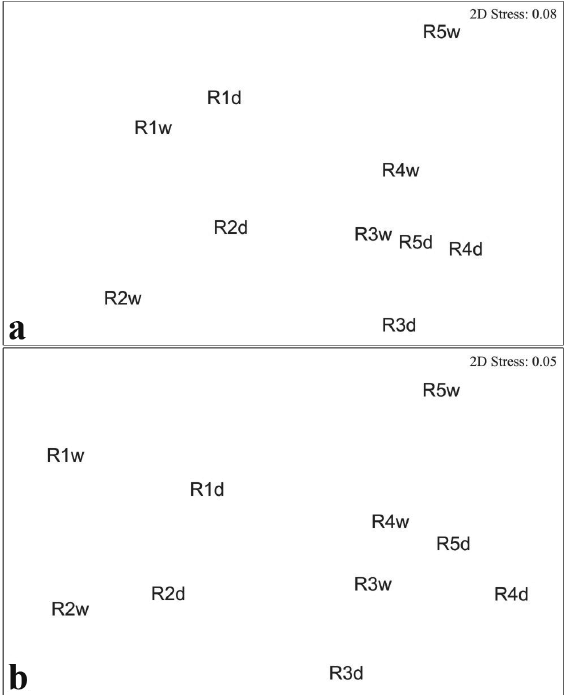
Fig. 2. Two-dimension ordinations based on Jaccard similarity coefficient (a) and on Bray-Curtis (b), considering the ten samples from the wet and dry seasons from the Correntes stream, central west